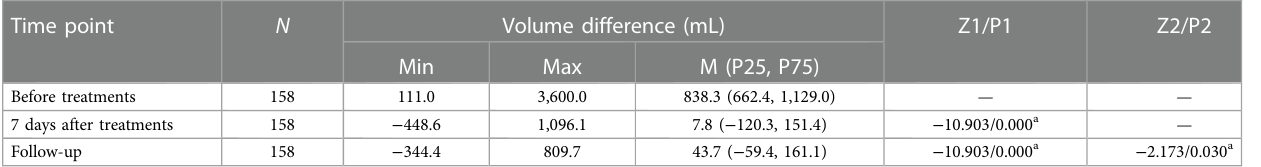
TABLE 3 Volume difference of bilateral arms before and after liposuction followed by lymphovenous anastomosis. Time